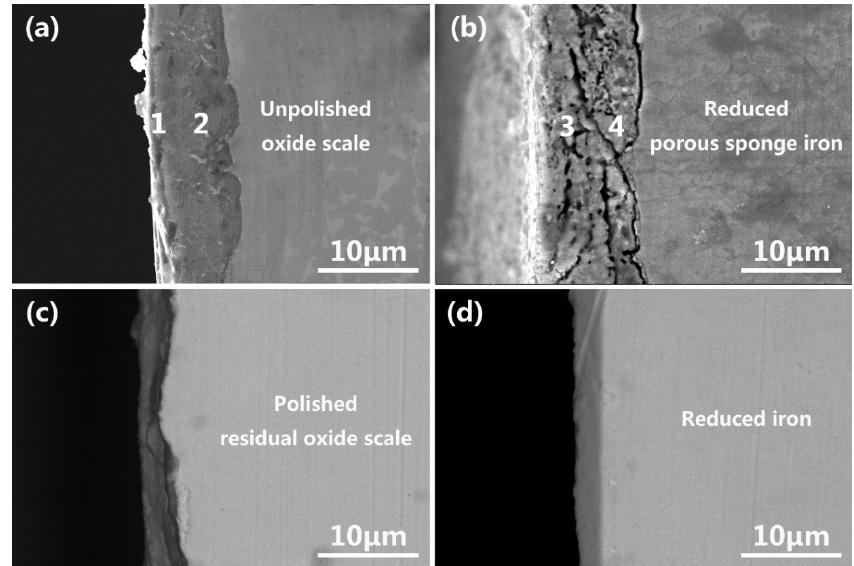
Figure 2. Microstructure of cross section of oxide scale of steel plate. ( a ) Unpolished steel plate before reduction, ( b ) Unpolished steel plate after reduction, ( c ) Polished steel plate before reduction, ( d ) Polished steel plate after reduction.